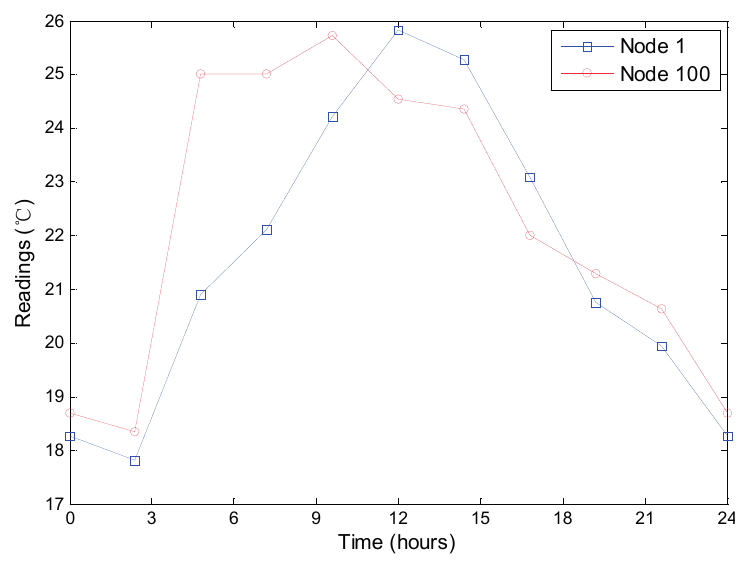
Figure 14. An example of the readings of a node in a